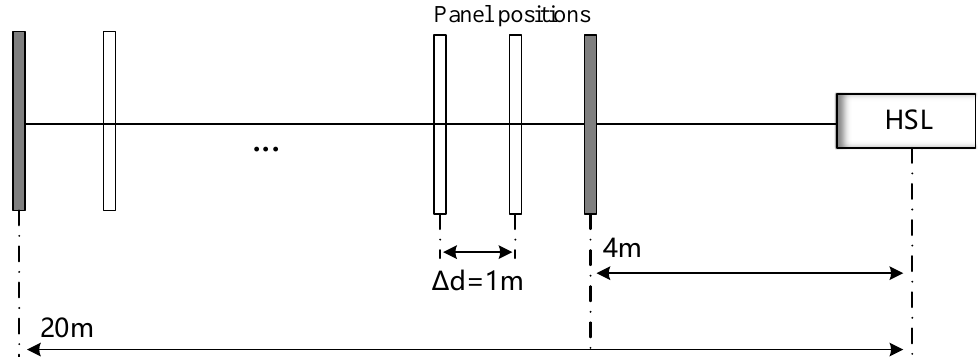
Figure 3. Measurement setup of experiment 2 with distance from 4 to 20 m, and a step interval of 1 m.